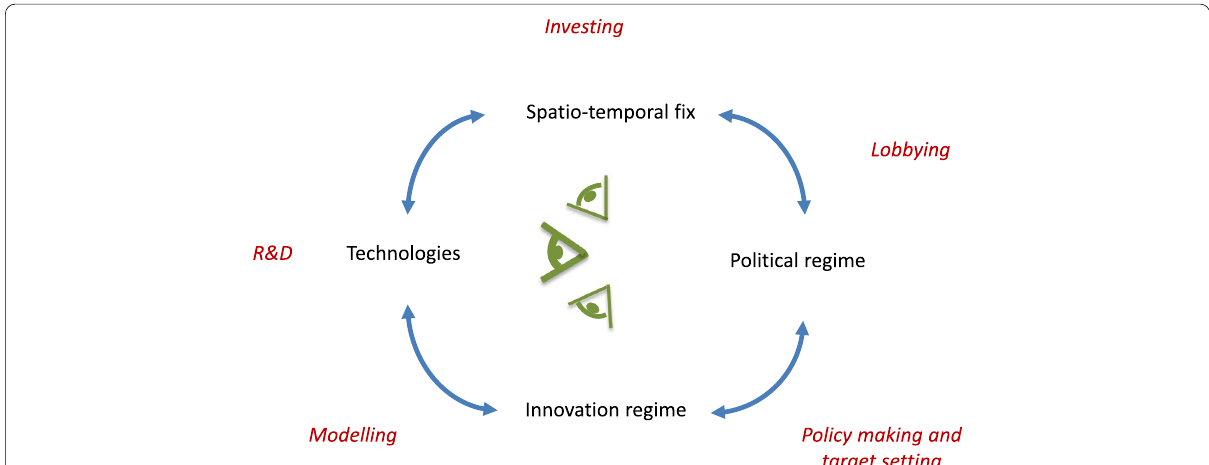
Fig. 2 Practices of the cultural political economy of mitigation deterrence. Note: practices indicated in red italics, located approximately where they are implicated in the